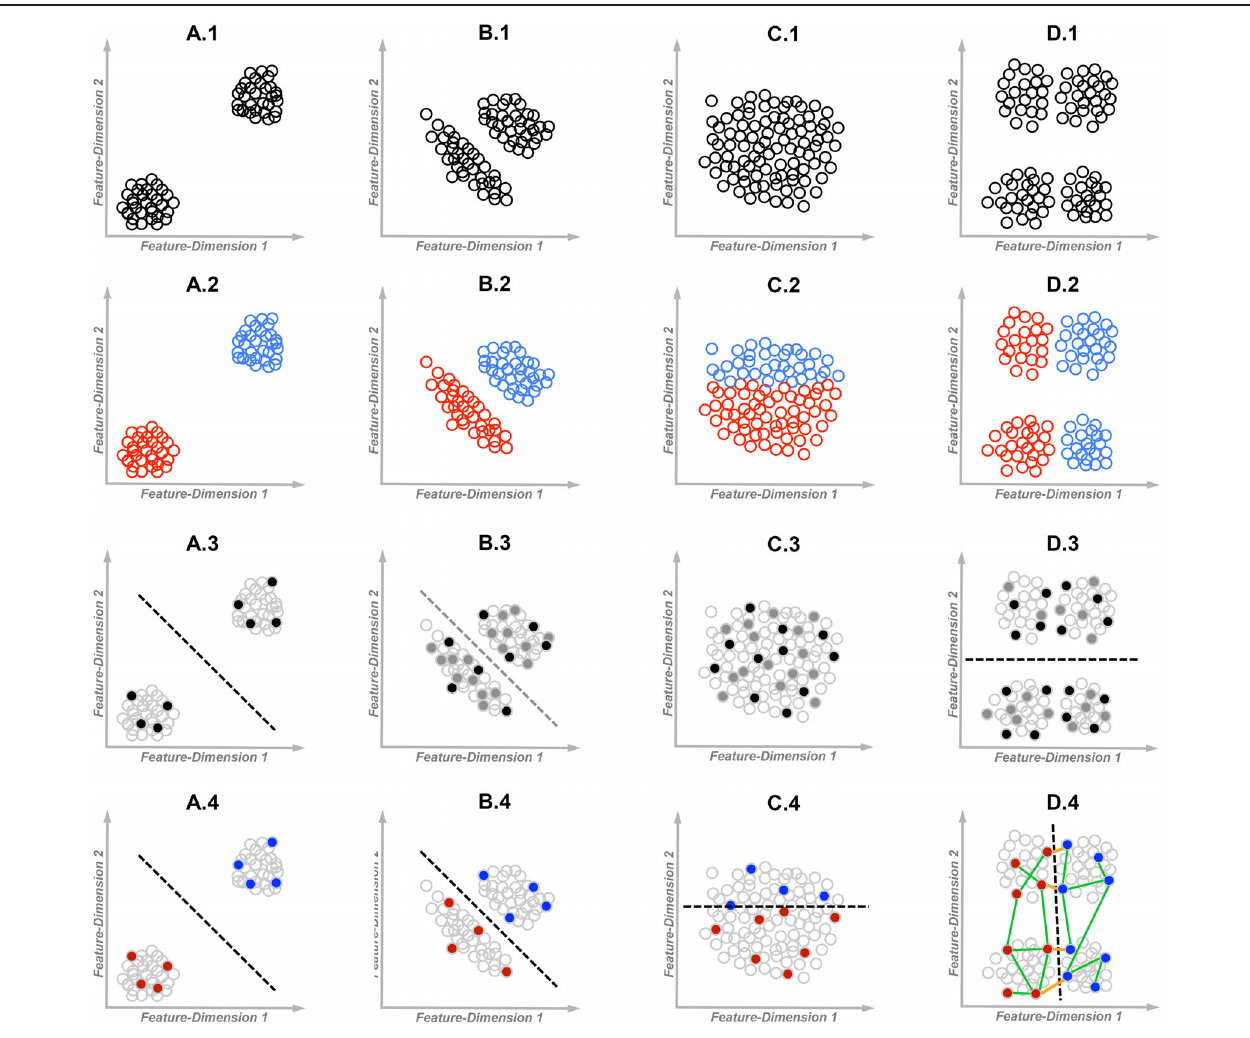
FIGURE 1 | Examples of different visual category learning (VCL) scenarios from the least dependent (A) to the most dependent (D) on supervision. Each dot represents an exemplar, where exemplars may differ in two visually perceived feature dimensions. Dashed lines represent the likely to be deduced category decision boundaries. Row-1 : The unlabeled data sets; Row-2 : The fully color-labeled data sets; Row-3 : Filled dots represent the